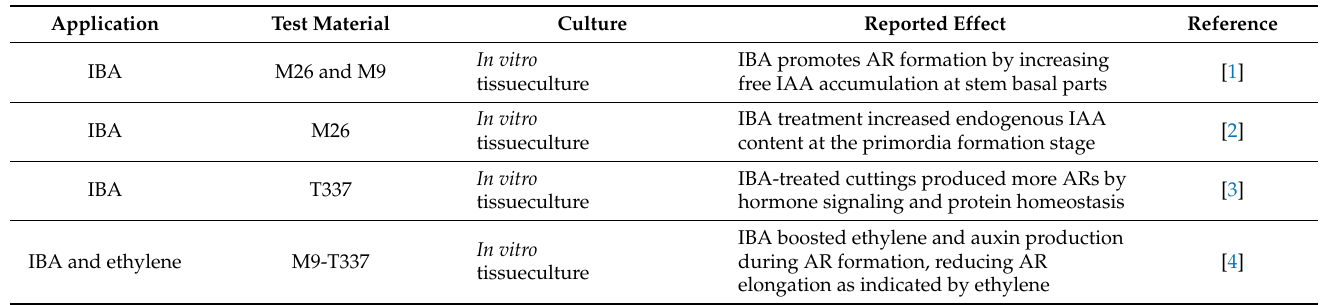
Table 1. A summary of the described effects of exogenous hormones, sugars, polyamines, and nutrients on adventitious rooting in apple stem